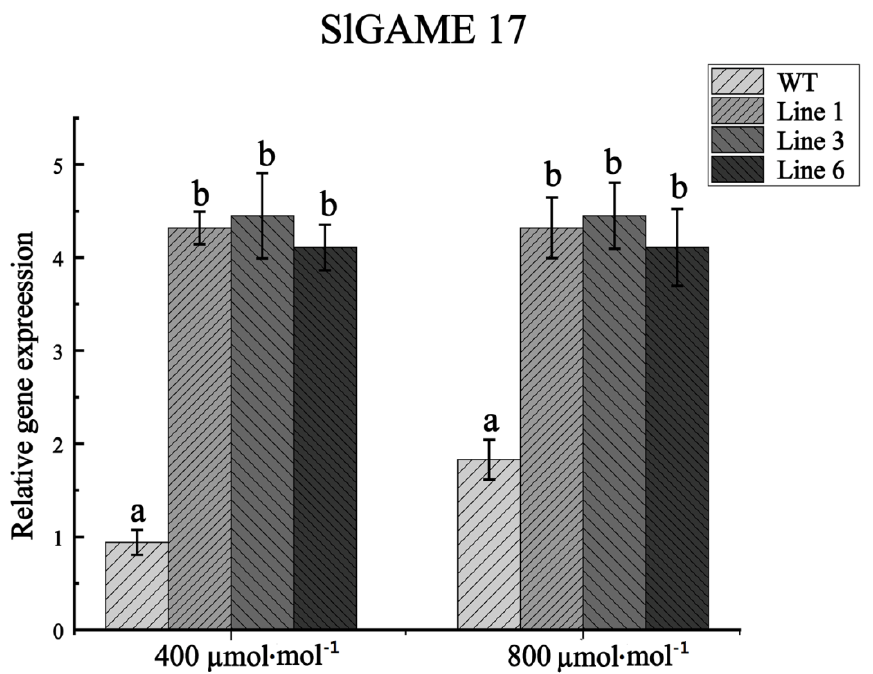
Figure 6. The expression level of GAME 17 in transgenic tomato and WT plants. (a) The expression level of GAME 17 in transgenic tomato and WT plants under natural conditions. (b) The expression level of GAME 17 in transgenic tomato and WT plants under high-CO 2 conditions. Data are means ± SD, n = 3.